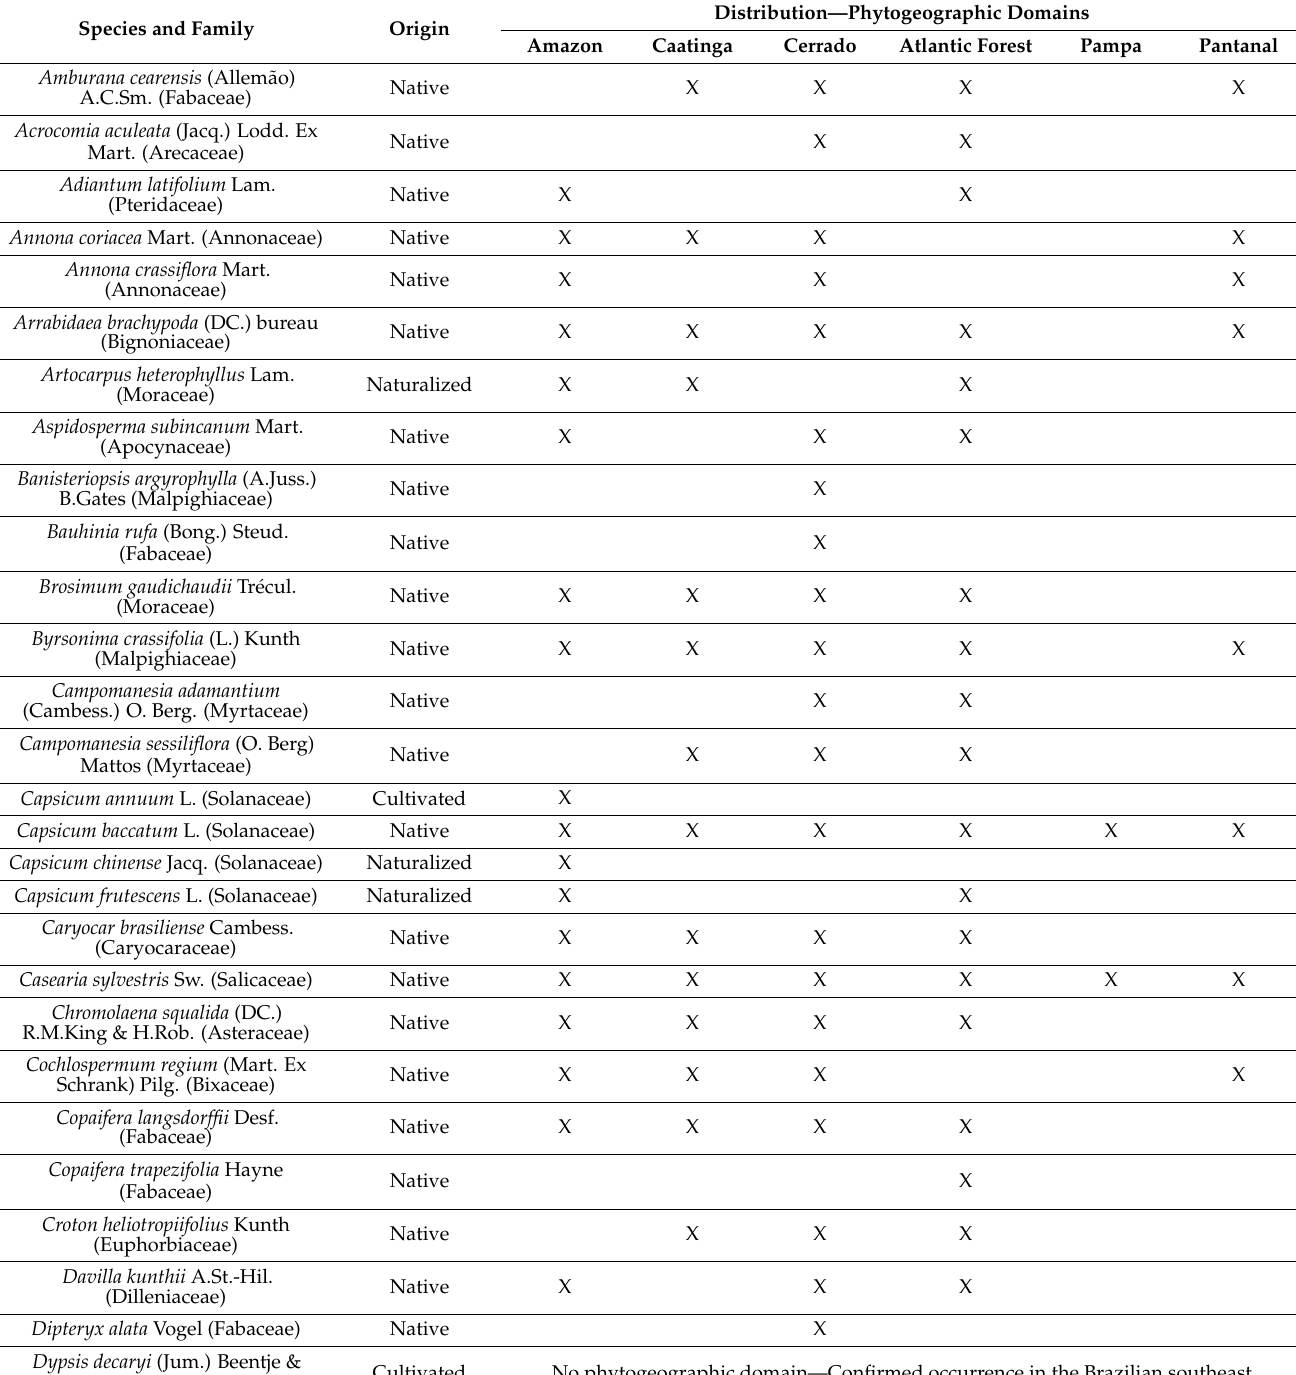
Table 1. Origin and distribution with phytogeographic domains of the prospected vegetable species studied for antimicrobial